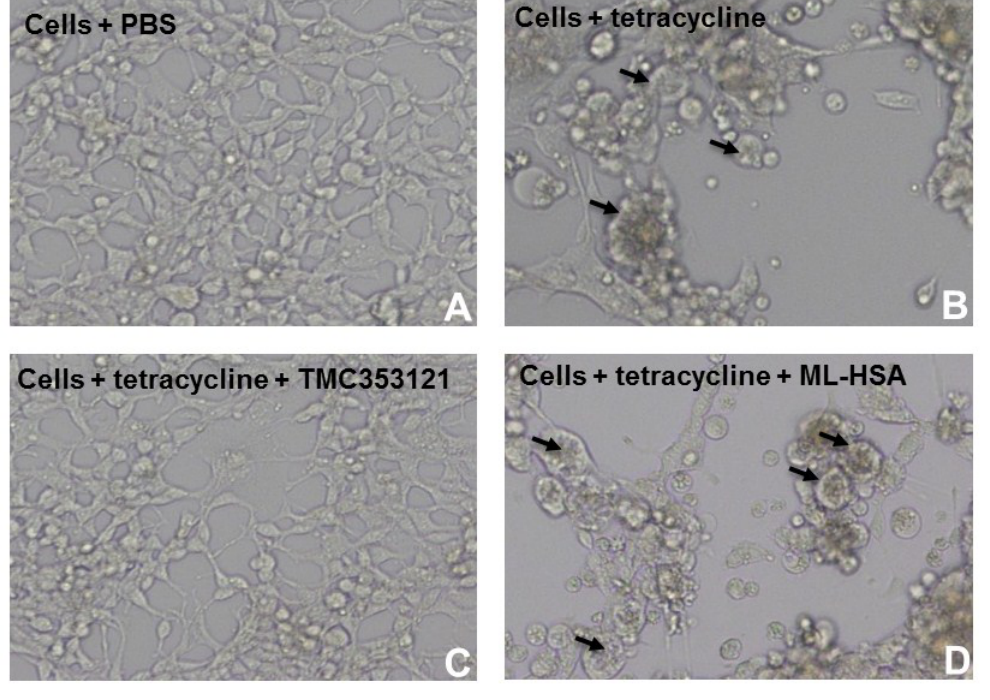
Figure 5. ML-HSA could not inhibit cell-cell fusion (or syncytium formation) mediated by F protein of RSV. 293-F cells expressing F protein of RSV induced by tetracycline was constructed. 293-F cells without tetracycline ( A ); 293-F cells with tetracycline ( B ), the arrows show the syncytia; 293-F cells with tetracycline in the presence of TMC353121 (200 nM), an F protein inhibitor ( C ); and 293-F cells with tetracycline in the presence of ML-HSA (1,000 nM) ( D ), and the arrows show the syncytia. Cell-cell fusion or syncytium formation was observed under a